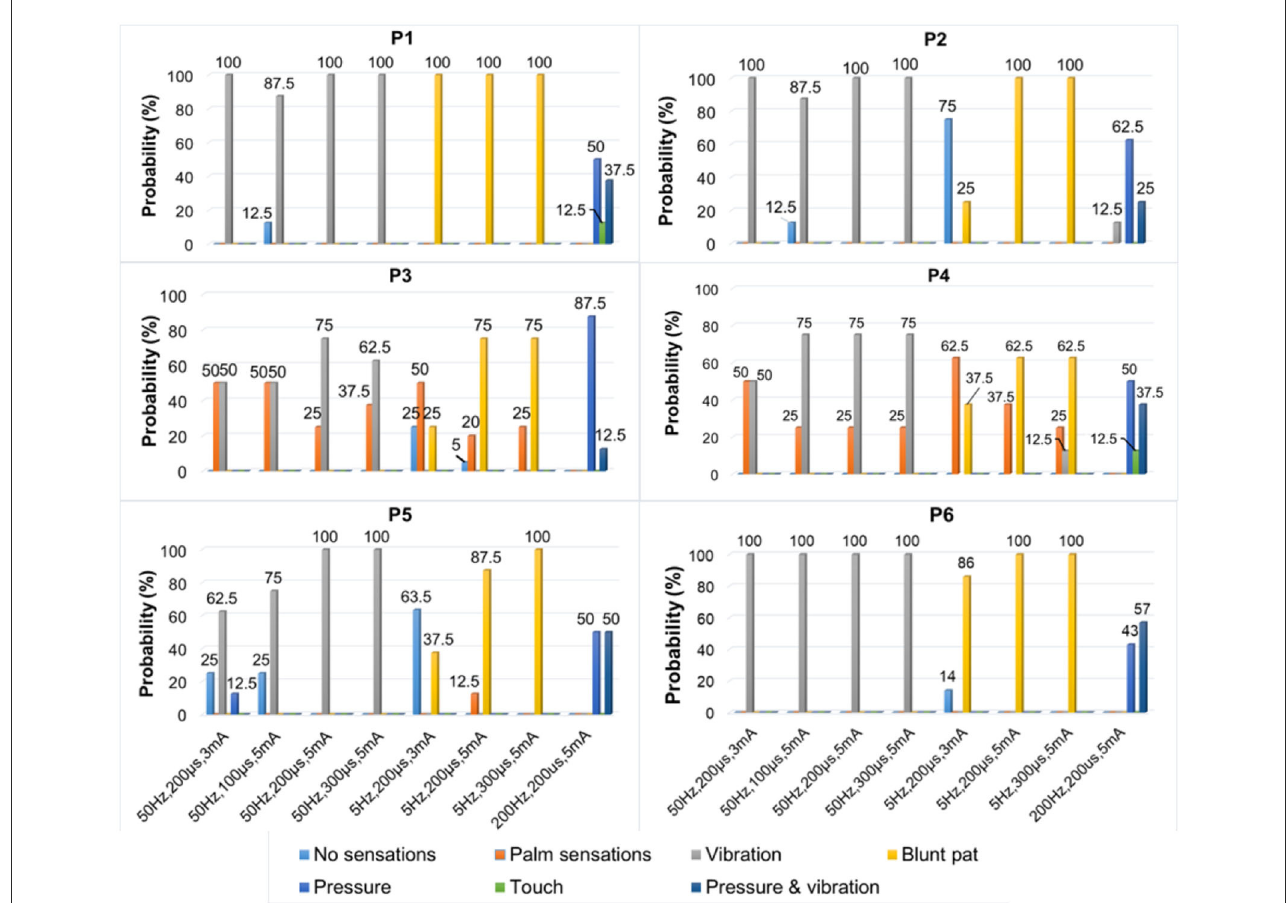
FIGURE7 The types of evoked sensations when the six selected positions were stimulated by the TENS with selected parameters under the SS mode.